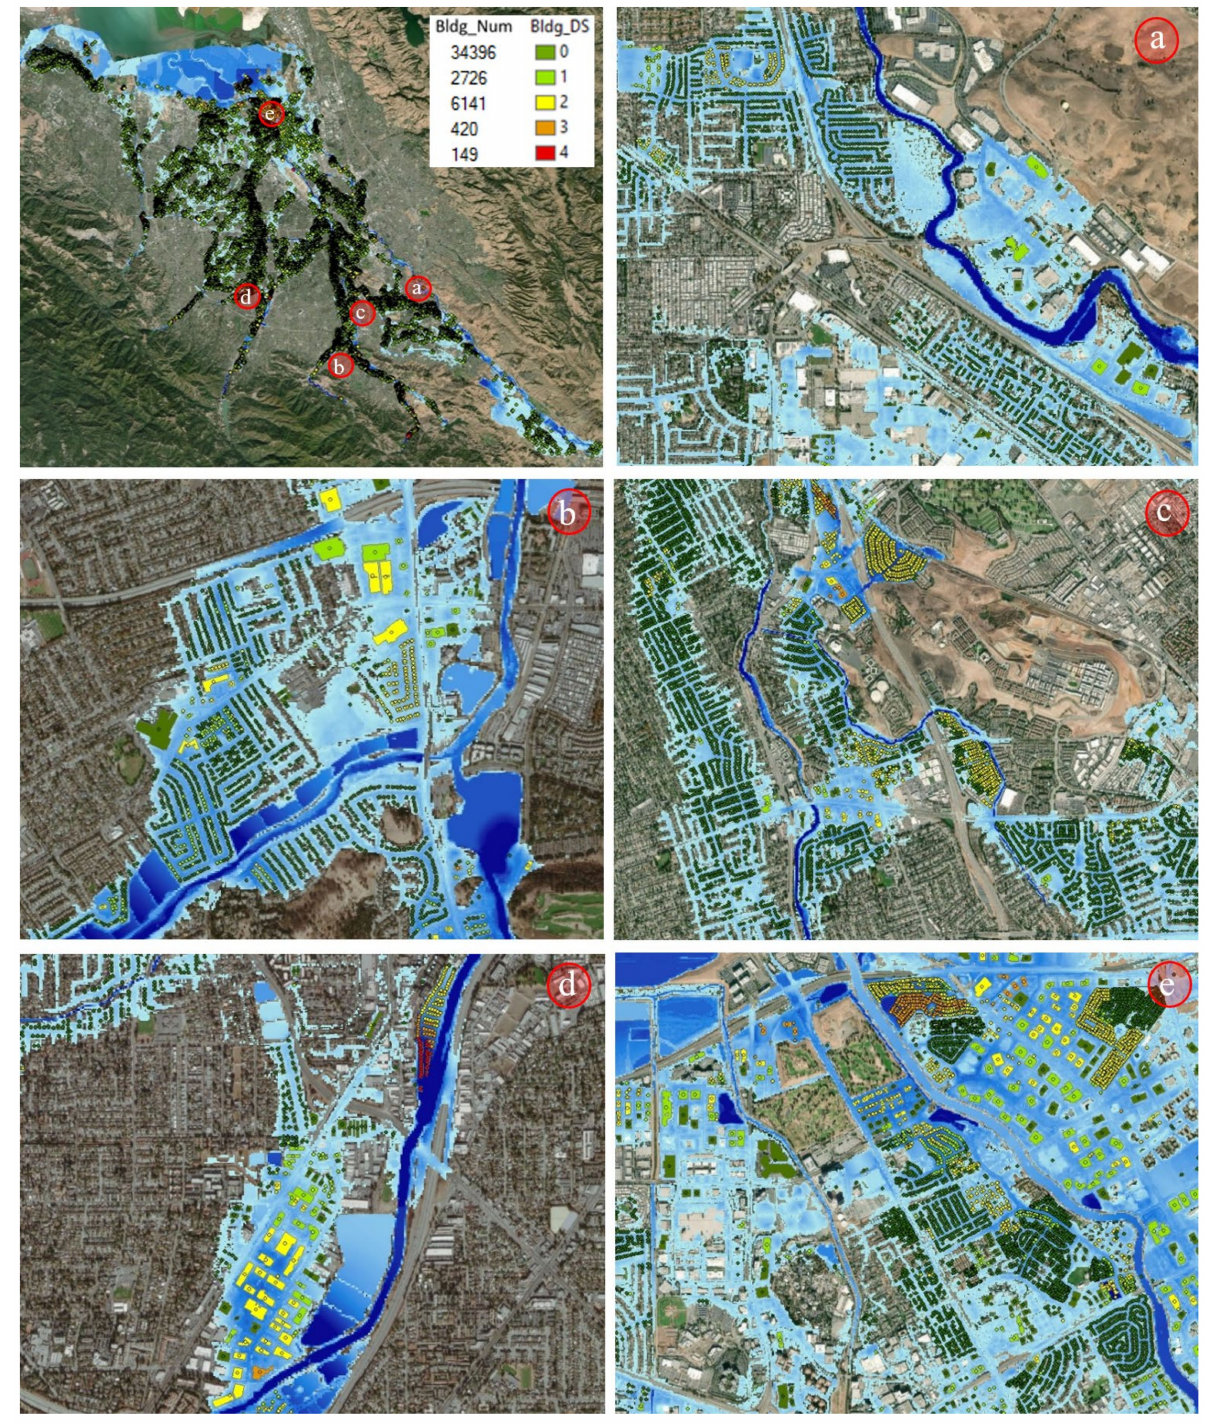
Figure 14. A color-coded map for Santa Clara County based on buildings damage states with close-up views on multiple locations as shown in ( a – e